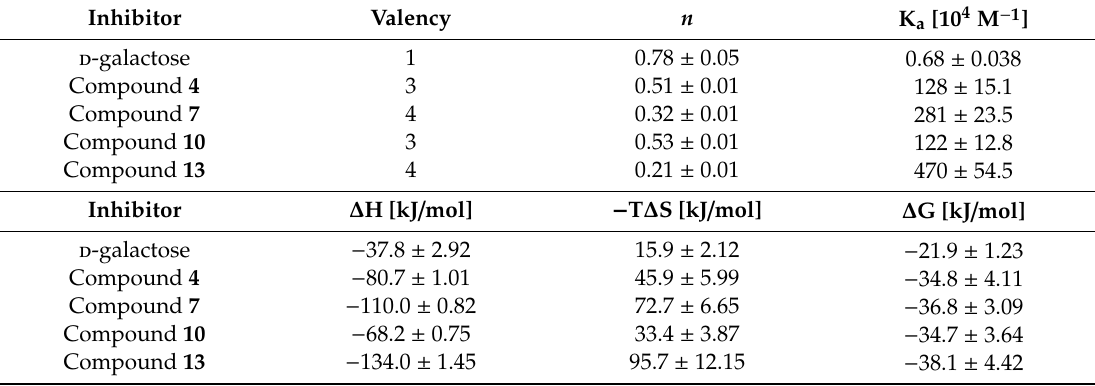
Table 3. Thermodynamic parameters of the interactions between lectin PA-IL and the tested inhibitors. Inhibitor Valency n K a [10 4 M − 1